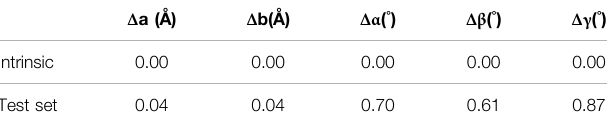
TABLE 3 | Reconstruction error in the cell parameters for 2D